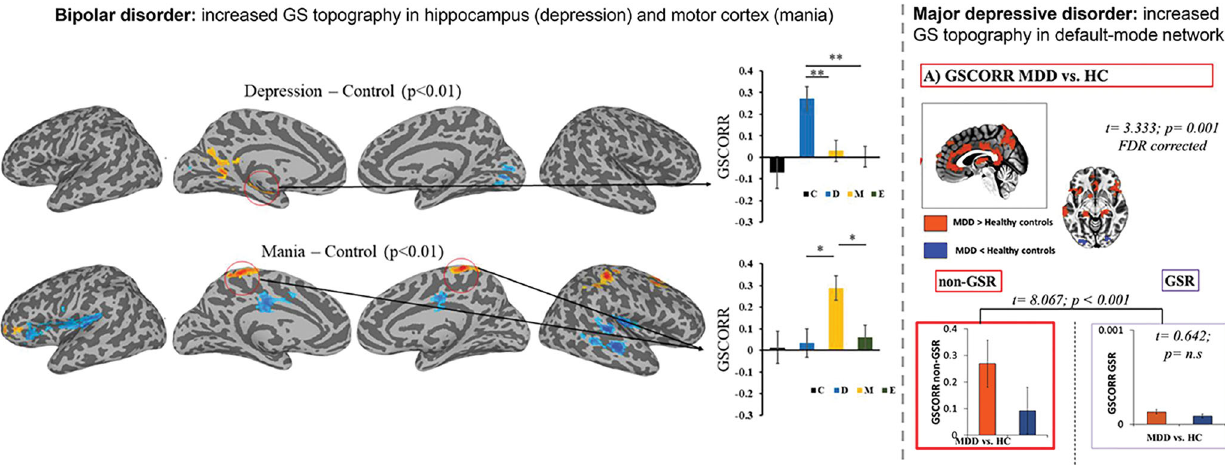
Fig. 2 Altered GS topography in different psychiatric disorders. The GS topography is signi fi cantly altered in the different phases of bipolar disorder, with increased GSCORR in hippocampus (and parahippocampus/fusiform gyrus) in bipolar depression and motor cortex in bipolar mania (from Zhang et al. 22 ). In major depressive disorder, the GS topography is increased in default-mode regions that shows abnormally strong global functional connectivity with all other regions, i.e., non-DMN in the rest of the brain (from Scalabrini et al. 89 ). GS Global signal, GSCORR Global signal correlation, C Control group, D Depression, M Mania, E Euthymic, MDD Major depressive disorder, HC Healthy control, GSR Global signal